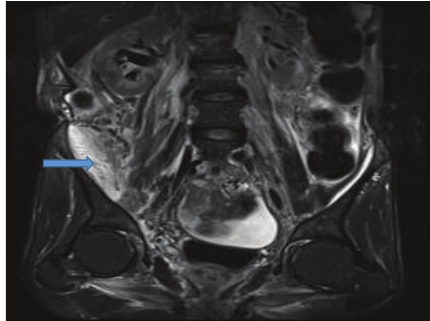
Figure 2: T2 coronal MR imaging showed enlarged predominantly hyperintenserightpsoasandiliopsoas(aspointedbyarrow)without any discrete fluid collection. Right kidney displaced anteriorly and laterally.